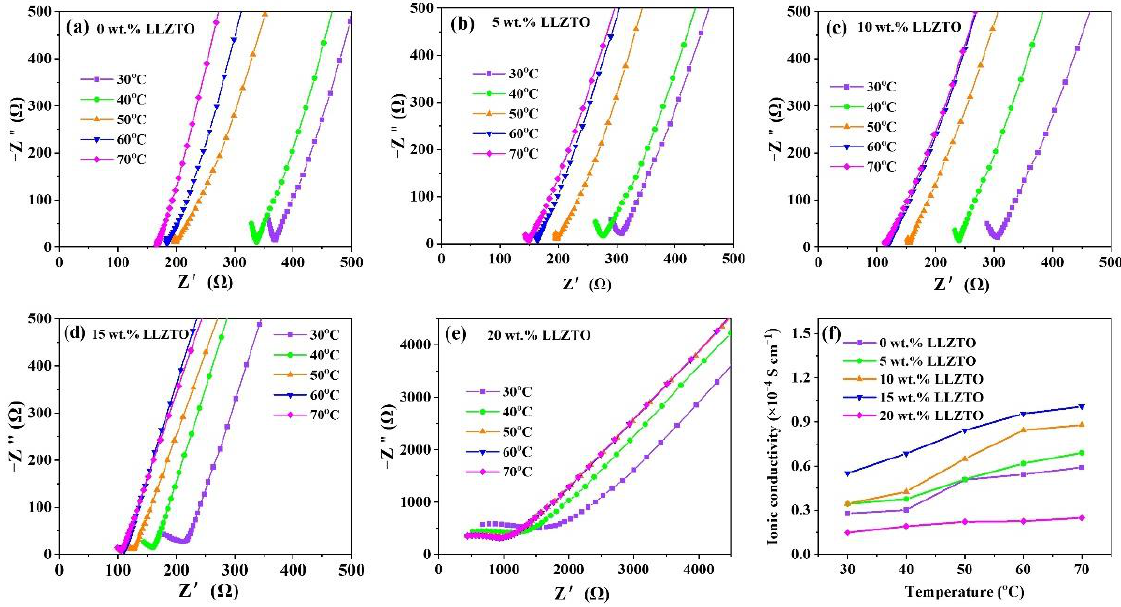
Figure 2. ( a – e ) EIS and ( f ) corresponding calculated ionic conductivity of CSE with different LLZTO content at different temperatures.